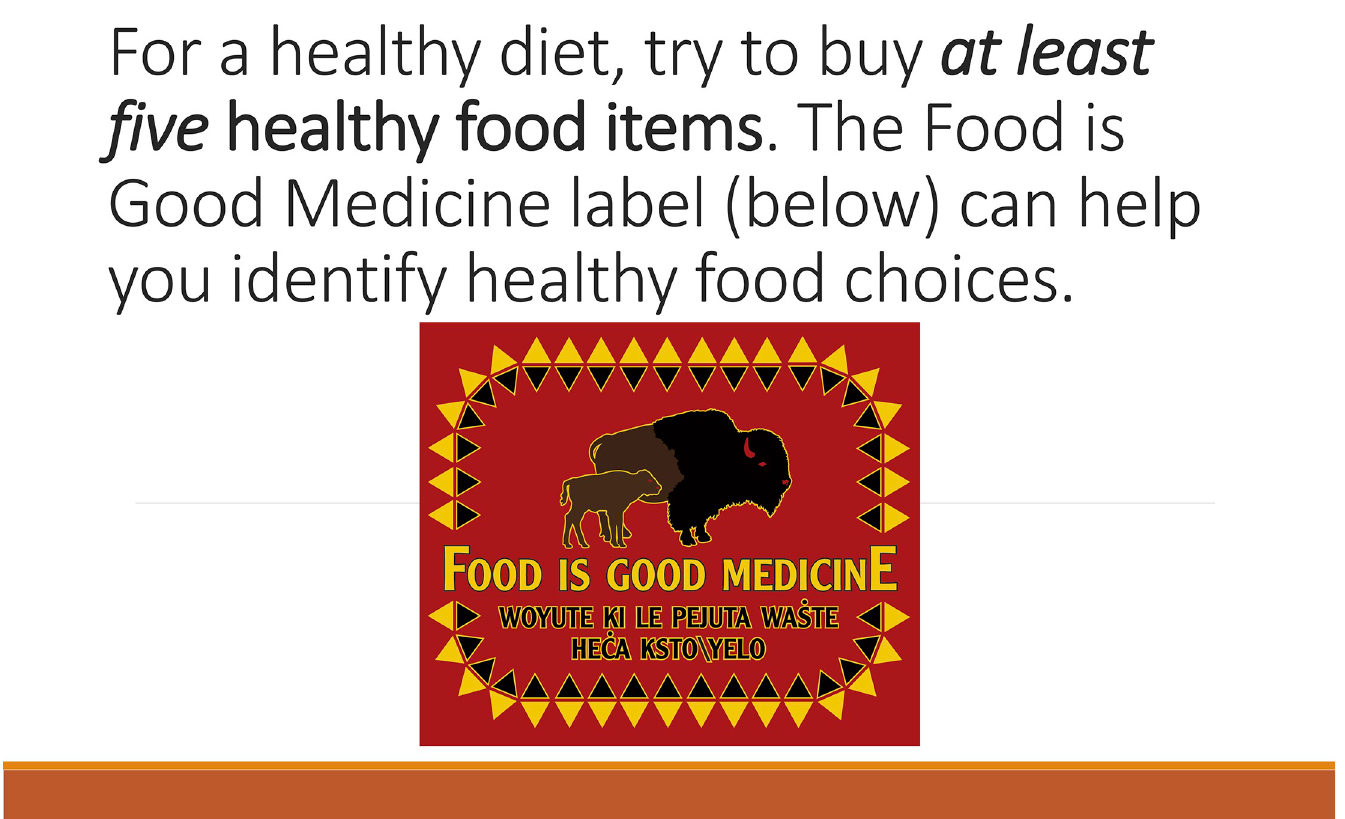
Fig 1. Poster with point of decision prompt for the broad prompt